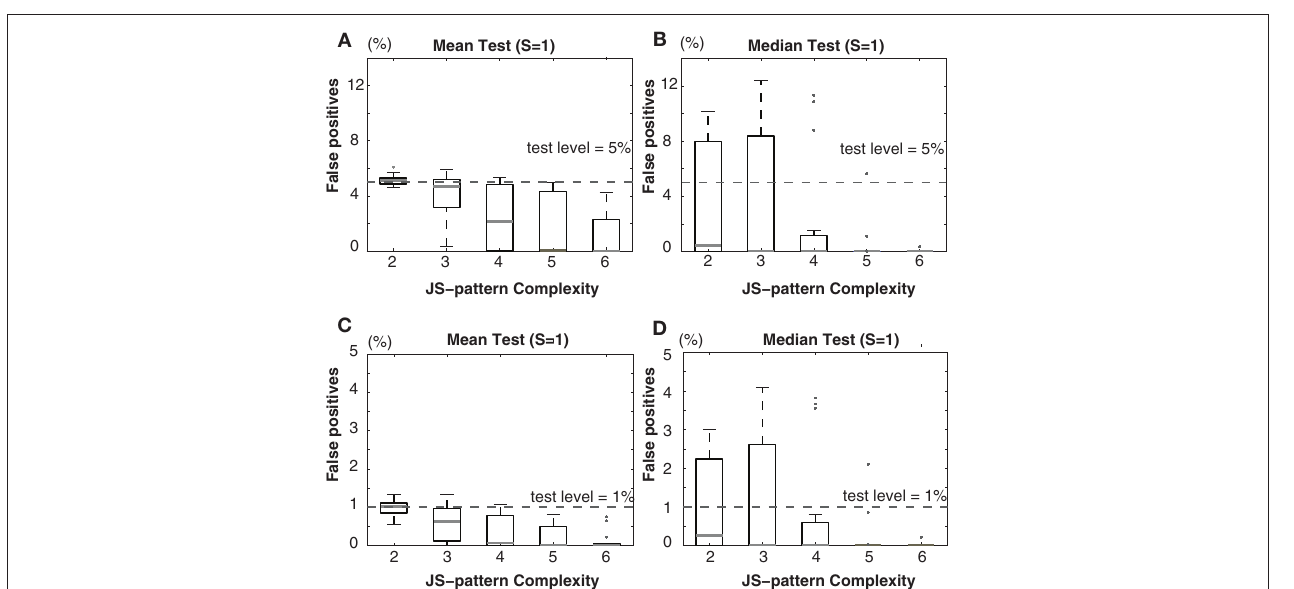
medians. The standard set of parameters for scenario II is defined by 50 trials ( T ), a mean spike rate of 15 spikes/s ( r ), one surrogate sample ( S ), and h equal to 5. From the standard parameter set, 15 different combinations of parameters are derived by using all combinations of the number of trials ( T = 20, 50, 100) and the second mean spiking rate ( r